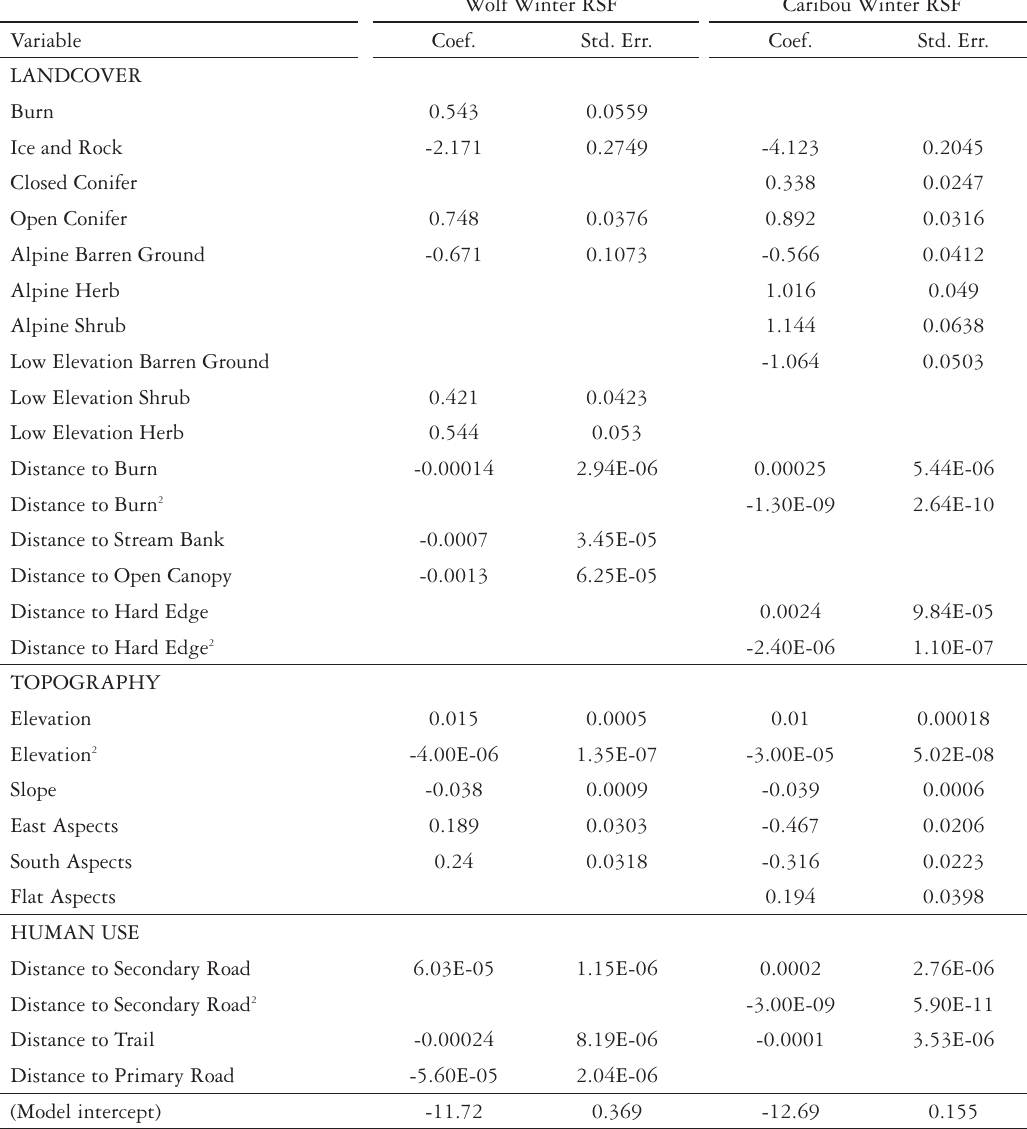
S-table 6. Wolf and Caribou winter resource selection function (RSF) models for Banff and Jasper National Parks. Covariates without coefficients were non-significant in our stepwise model selection process and thus cat- egorical variables (landcover type and aspect) without coefficients are included in the model intercept or constant term. For distance variables a positive coefficient shows avoidance (i.e., use increases with distance) while negative coefficients show selection (i.e., use decreases with distance). Squared variables are quadratic terms. All variables included in the models were significant at a level ≤